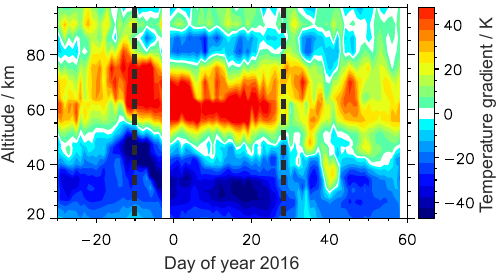
Figure 5. Altitude–time cross section of the meridional tempera- ture gradient between 80 and 40 ◦ N derived from MLS above the European sector defined as 0–30 ◦ E. The temperature gradient is obtained using bins of 5 ◦ in latitude.